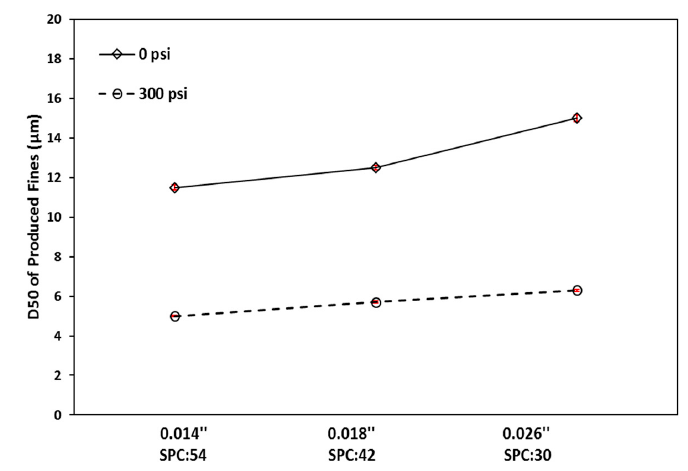
ff ect of slot size and density on d50 of produced Figure 16. Effect of slot size and density on d50 of produced fines. Figure 16. E